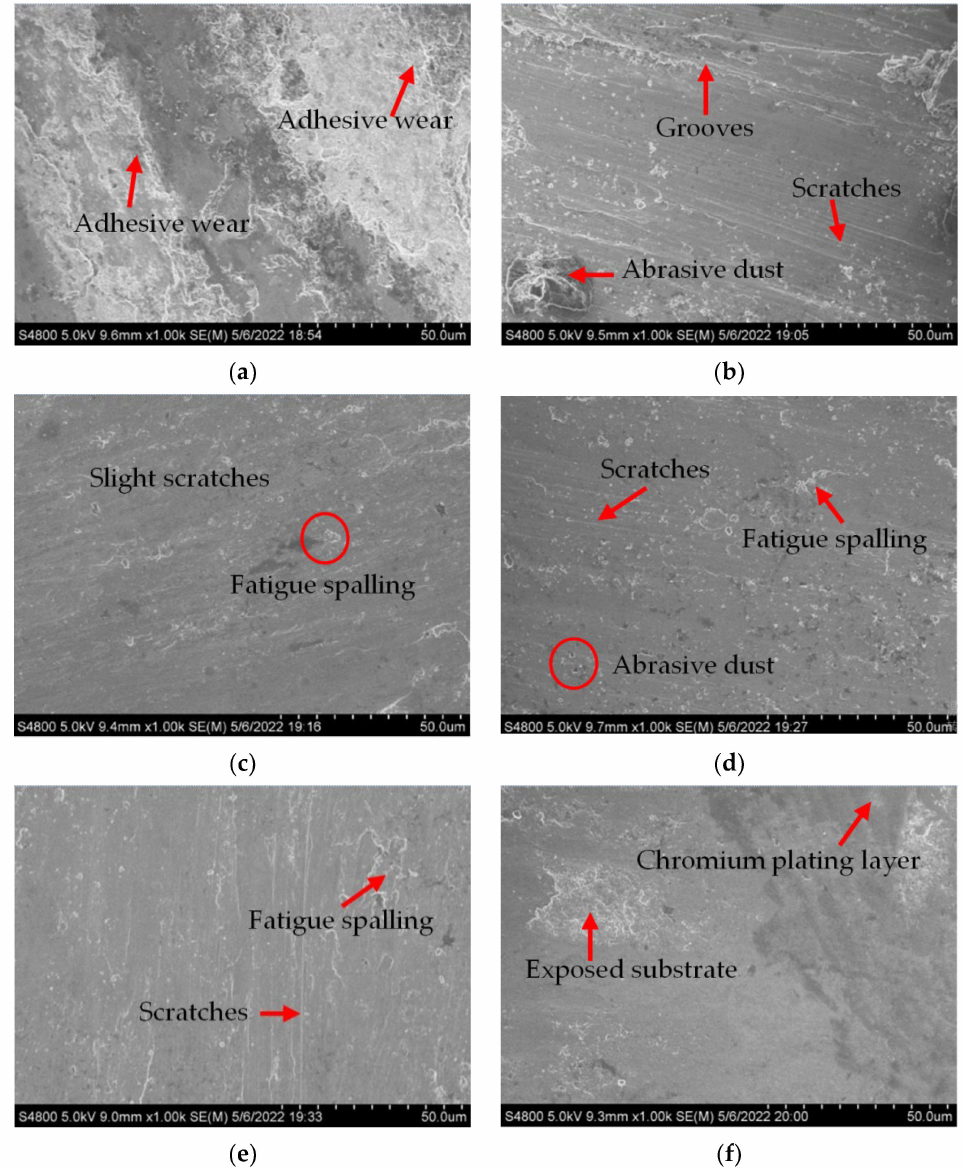
Figure 25. The worn surfaces of different coatings: ( a ) substrate; ( b ) 2#; ( c ) 5#; ( d ) 6#; ( e ) Cladding layer 5# after aging for 16 h; and ( f ) the chromium plating